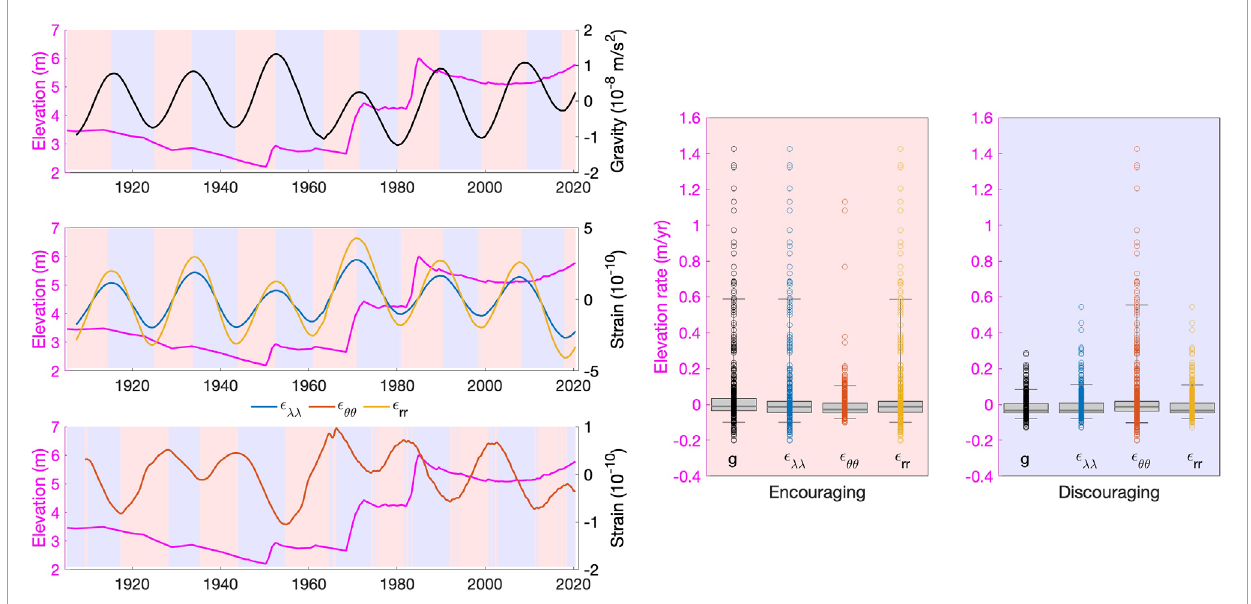
FIGURE 6 Left: comparison of the elevation (in violet) at the RITE station over the 20th century with the gravity changes and strain changes induced by lunisolar tides and Earth’s rotation. The strain components are as follows: ϵ λλ is the horizontal, eastward component of the surface strain tensor, ϵ θθ is the horizontal, southward component, and ϵ rr is the radial (vertical) component. The curves relevant to gravity, ϵ λλ , and ϵ rr are lagged by 2 years; the curve relevant to ϵ θθ is lagged by 4 years. The pink bands indicate the positive phase; the blue bands indicate the negative phases (see text for definition). Right: whisker plots of the distribution of the elevation rate in the positive and negative phases.